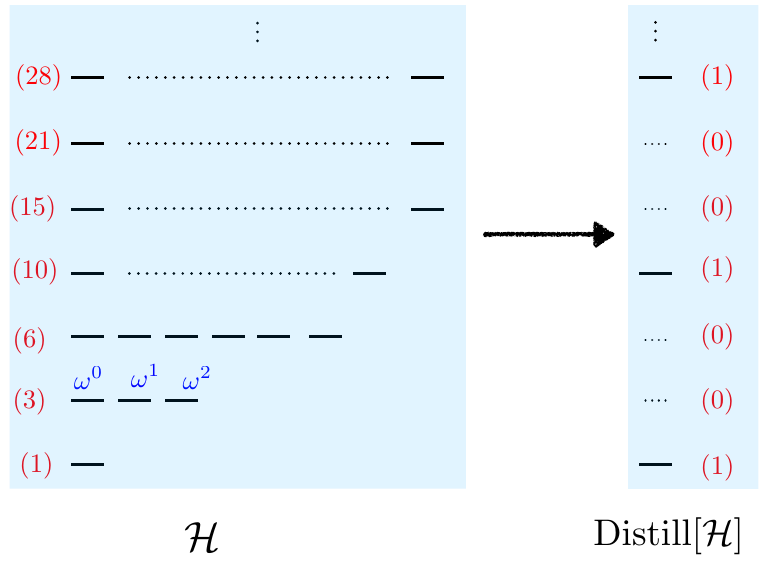
Figure 1 . Hilbert space of 3d simple harmonic oscillator and its SU(3) symmetry graded distilla- tion. The terms inside parenthesis indicate degeneracies. Despite its simplicity, this picture morally captures what takes place in 2d sigma models and 4d QCD(F/adj). In the N -dimensional oscillator as N → ∞ , only ground state contribute to symmetry graded partition function. This is also the case in the large- N limits of CP N − 1 sigma model and principle chiral model, as we review, where symmetry graded state sum exhibits spectral cancellations (similar to Witten index in supersym- metric theories), but now story can take place in purely bosonic